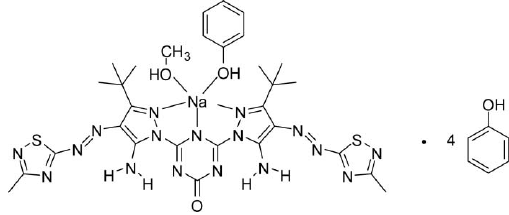
Key indicators: single-crystal X-ray study; T = 93 K; mean (cid:2) (C–C) = 0.006 A˚; H-atom completeness 99%; disorder in main residue; R factor = 0.064; wR factor = 0.196; data-to-parameter ratio = 12.6.